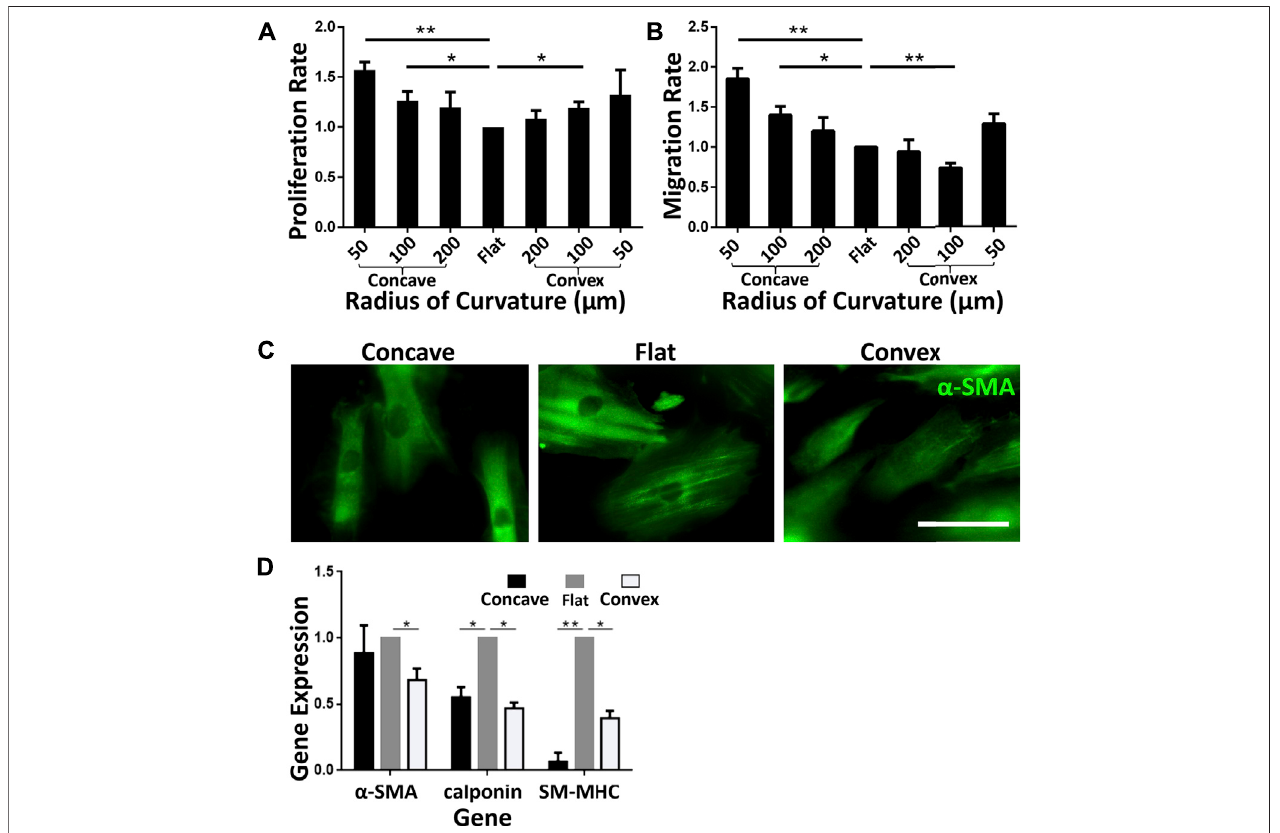
FIGURE 4 | Phenotypic transformation of ASMCs on curved surfaces (A) The proliferation rate of cells on different surfaces (B) Longitudinal migration rate on different curved surfaces (C) Fluorescence pro fi les of α -SMA of ASMCs on different curved surfaces (concave: R (cid:1) 100 μ m, fl at, convex: R (cid:1) 100 μ m, from left to right), scalebar (cid:1) 50 μ m (D) FoldchangesofmRNAexpressionof α -SMA,calponinandSM-MHCinASMCsculturedontheconcaveandconvexsurfacescomparedtothe fl at sruface. Data are presented as mean ± S.E.M, n (cid:1) 3, * p < 0.05, ** p <